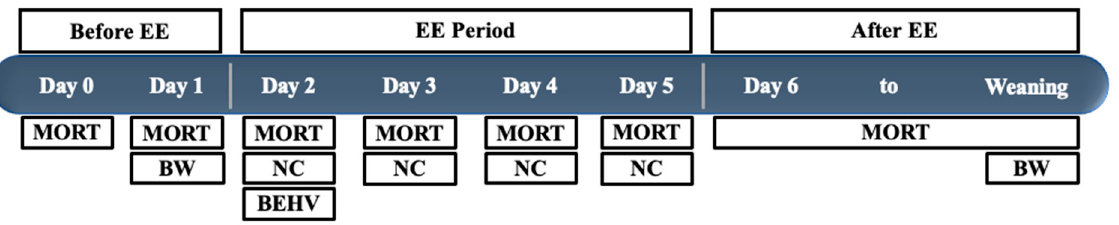
Figure 3. Timeline of the experimental period, and when each measure was collected. Day 0 began when the sow started to farrow, and each additional day begins 24 h after. The environmental enrichment (EE) ropes were placed in the stalls at the beginning of Day 2 and removed at the beginning of Day 6. Methods include BW (piglet body weight collected), BEHV (behavior observations collected), NC (dead piglets necropsied) and MORT (count and percent mortality collected).